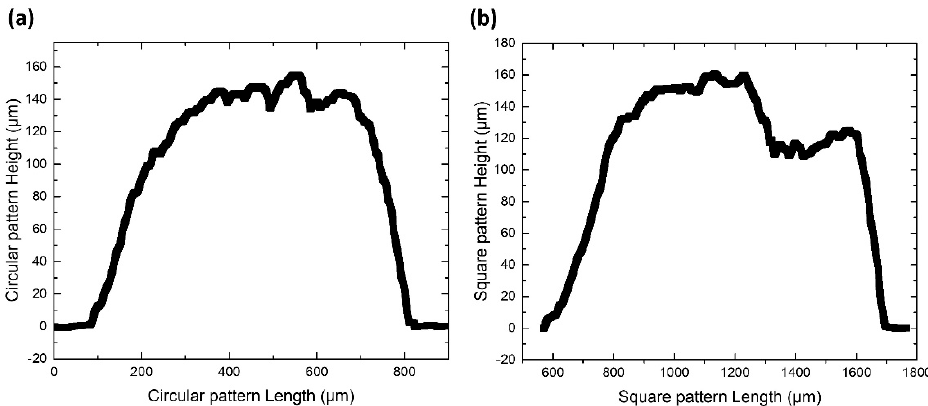
Figure 7. Profilometry measurement of ( a ) a circular printed pattern at 1.5 m/s, and ( b ) a square printed pattern at 1.5 m/s. Donor-receiver gap was fixed at 50 μ m and donor layer thickness was set by the film applicator at 150 μ m.